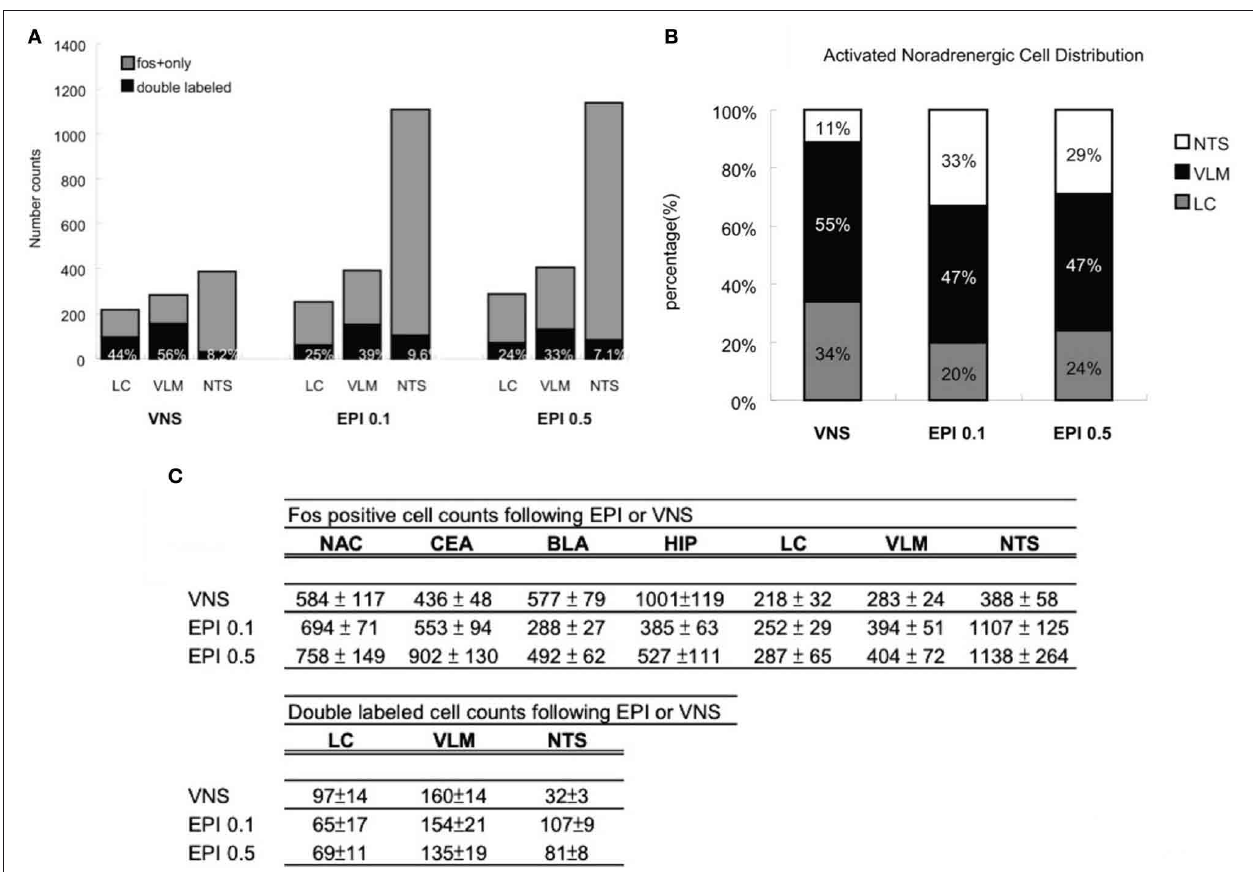
FIGURE 9 | (A) Percentage of noradrenergic of cell activation. Vagus nerve stimulation induces noradrenergic activation that accounts for 44% of the neuronal activity in the LC, 56% in the VLM, and 8.2% in the NTS. In addition, 0.1mg/kg epinephrine injection induces noradrenergic activation that accounts for 25% of the neuronal activity in the LC, 39% in the VLM, and 9.6% in the NTS. Moreover, 24% of the Fos activation in the LC, 33% in the VLM, and 7.1% in the NTS are attributed to activated noradrenergic cells induced by 0.5mg/kg epinephrine. (B) Activated noradrenergic cell distribution. In the vagus nerve stimulation group, out of the total double labeled cells of the three noradrenergic nuclei, 34% was contributed by the LC, 55% by the VLM, and 11% by the NTS. In the epinephrine 0.1mg/kg group, 20% was contributed by the LC, 47% by the VLM, and 33% by the